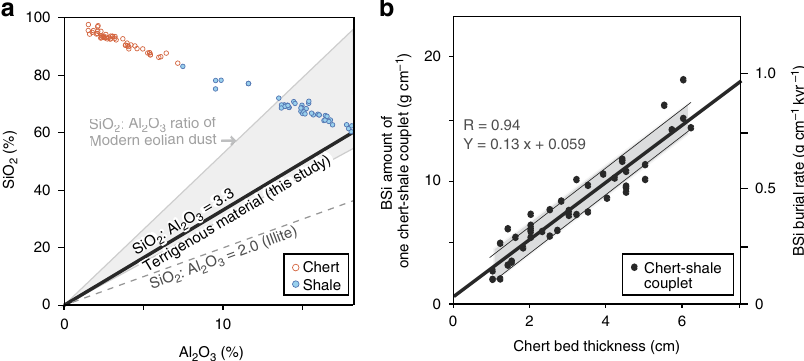
Figure 2 | Major element composition and BSi burial fluxes of bedded cherts. ( a ) Relationship between SiO 2 and Al 2 O 3 ( r ¼ (cid:2) 0.98) of shale and chert beds and ( b ) positive relationship between chert bed thickness and accumulation amount of BSi per 1cm 2 per one chert-shale couplet with the corresponding BSi burial flux per one couplet on the right side of figure for the Lower-Middle Triassic bedded chert in the Inuyama area, central Japan. The SiO 2 :Al 2 O 3 ratio of the sample with the smallest SiO 2 content among all the analysed shale samples in this study was within the range of SiO 2 :Al 2 O 3 ratio of the modern pelagic eolian dust 20 (Grey shade). The dashed line is the SiO 2 :Al 2 O 3 ratio of illite. Black line and grey shaded zone of ( b ) represent the regression line and standard deviation (1 s ), respectively. Flux is calculated assuming one chert-shale couplet as a B 20kyr precession